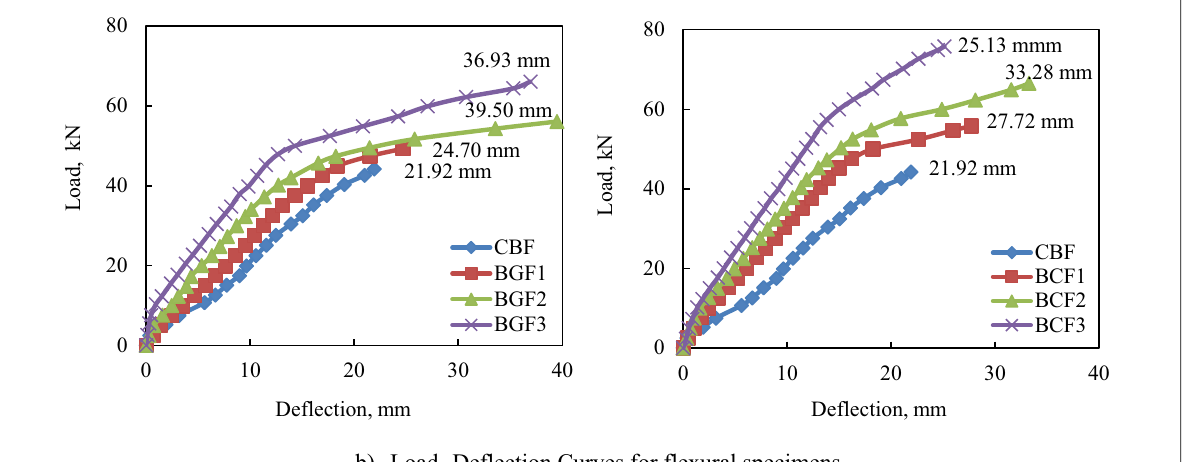
level for shear strengthened beams. It is evident that the